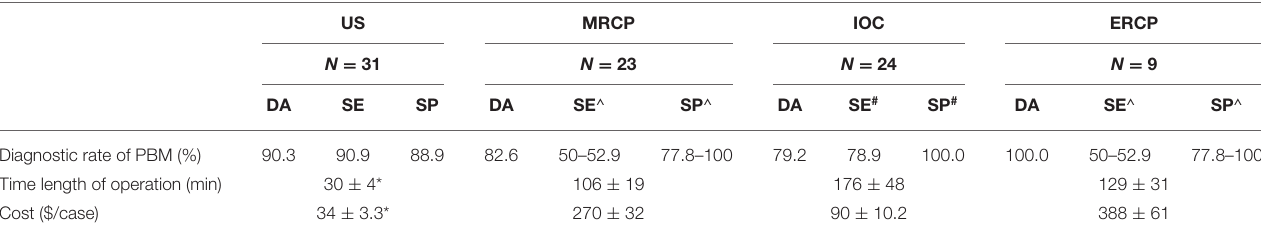
TABLE 2 | Overall diagnosis rates, time length of operation, and cost of service in pediatrics with